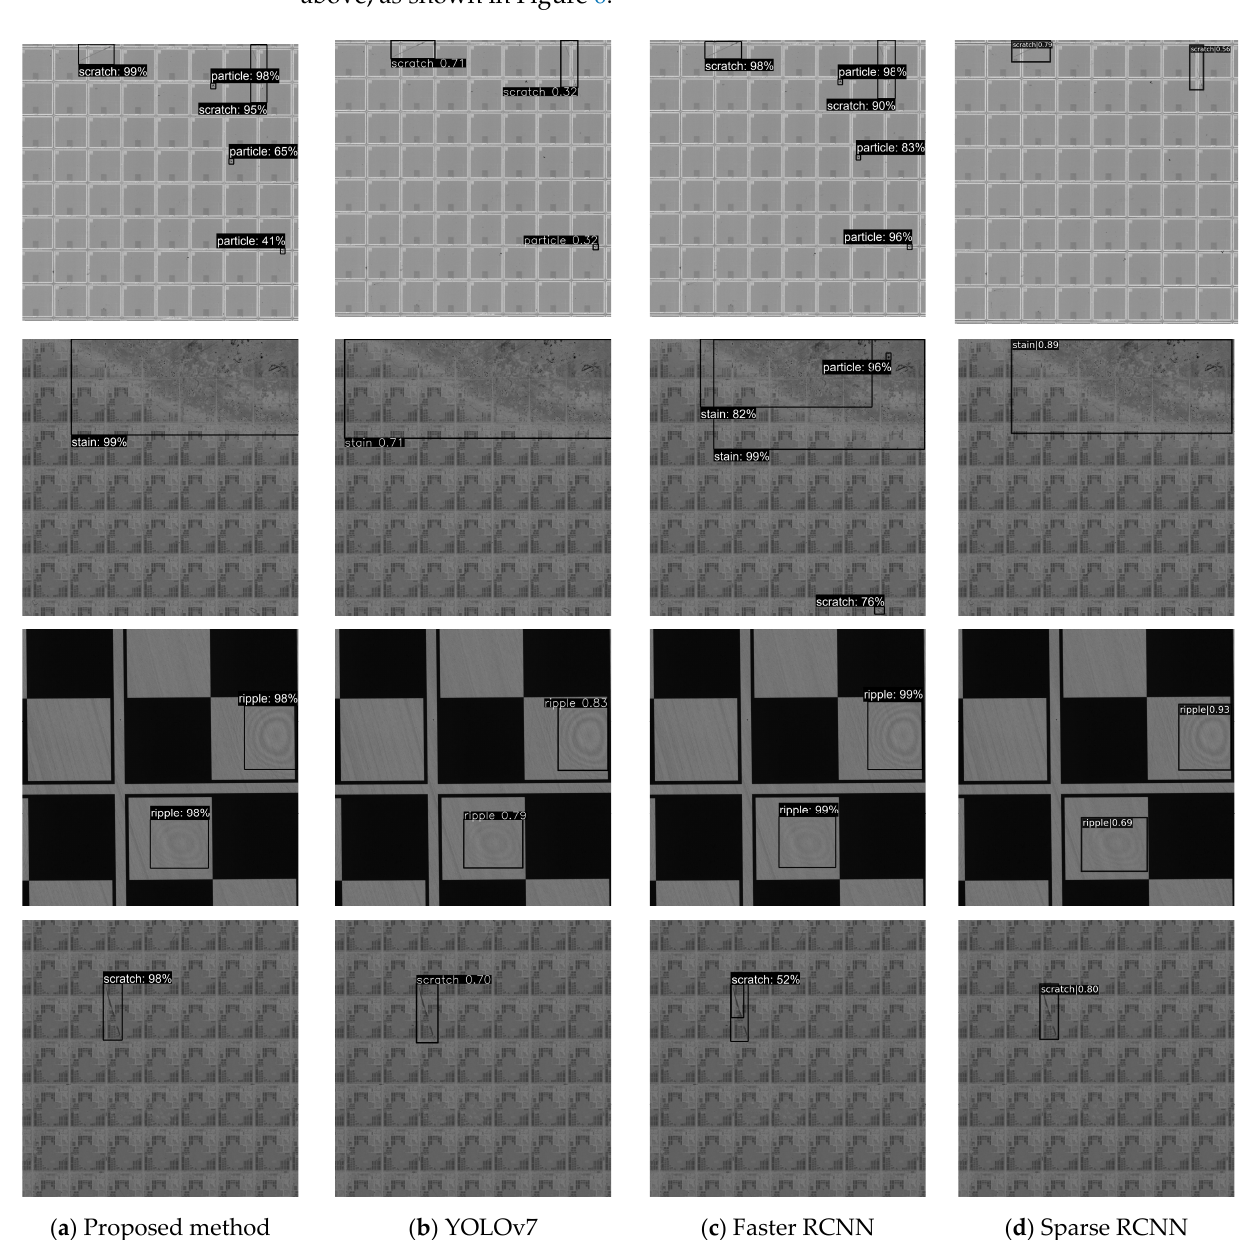
Figure 6. Qualitative results of different models.